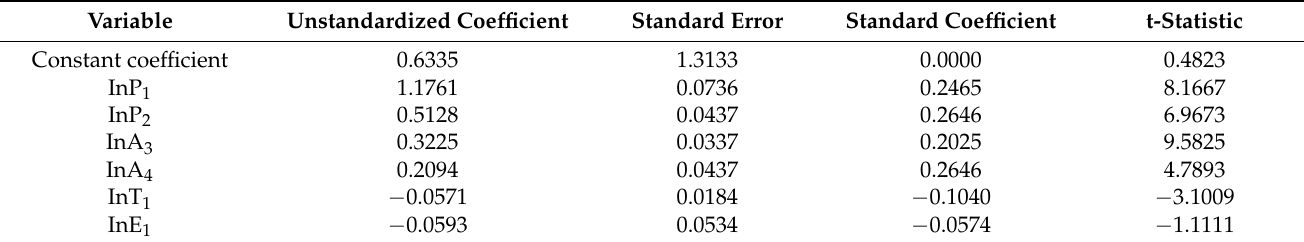
Table 6. Jiangsu Model Test Results.